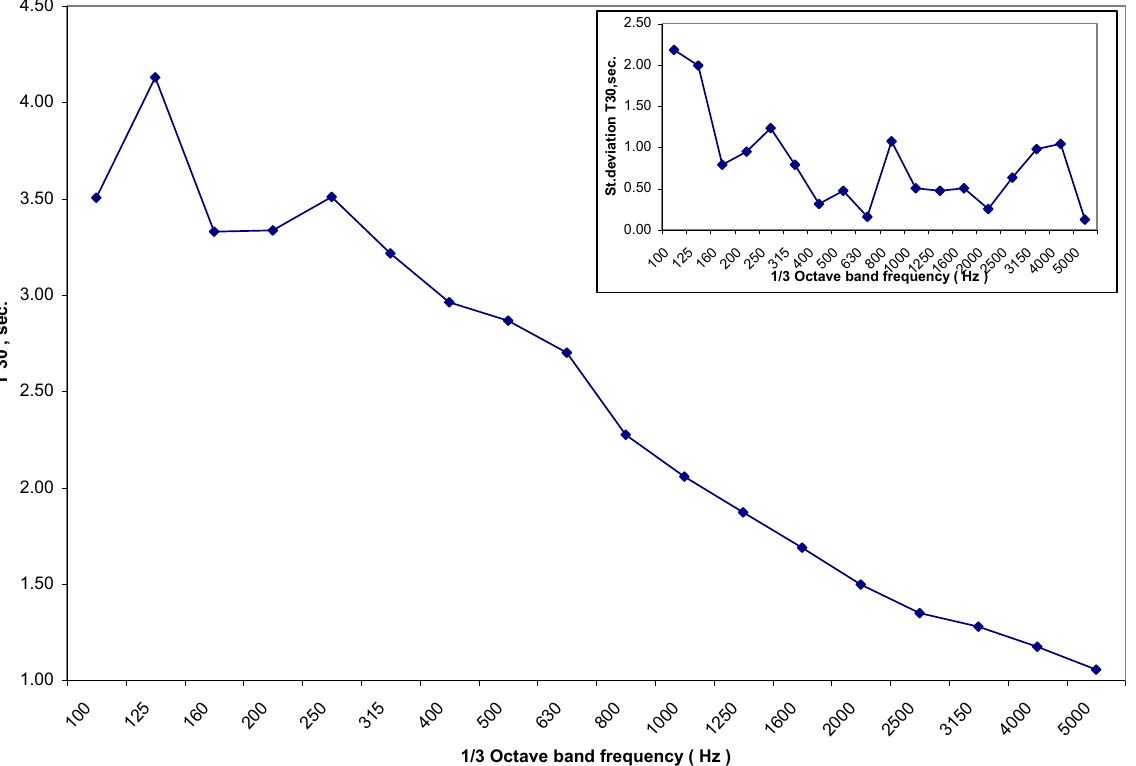
Fig. 5. Average values of reverberation time T 30 (s) in the receiving room together with standard deviations (inset fi